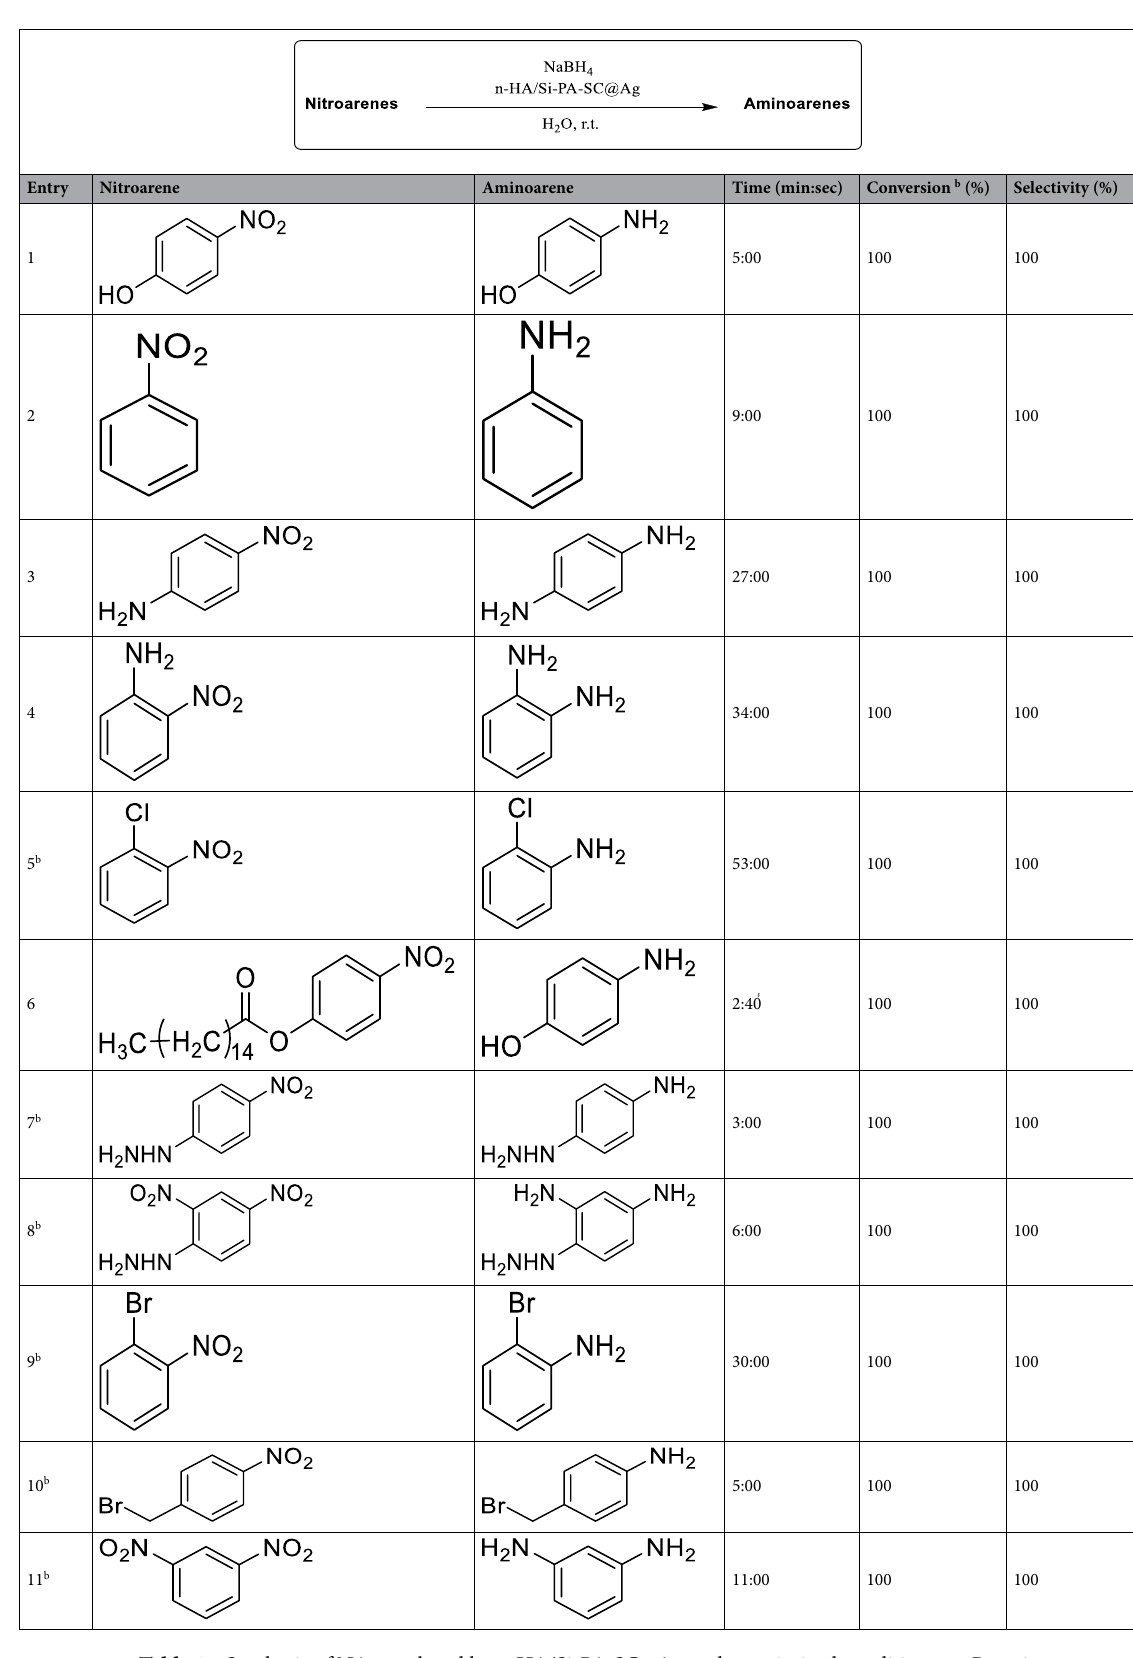
Table 1. Synthesis of NAs catalyzed by n-HA/Si-PA-SC@Ag under optimized conditions a . a